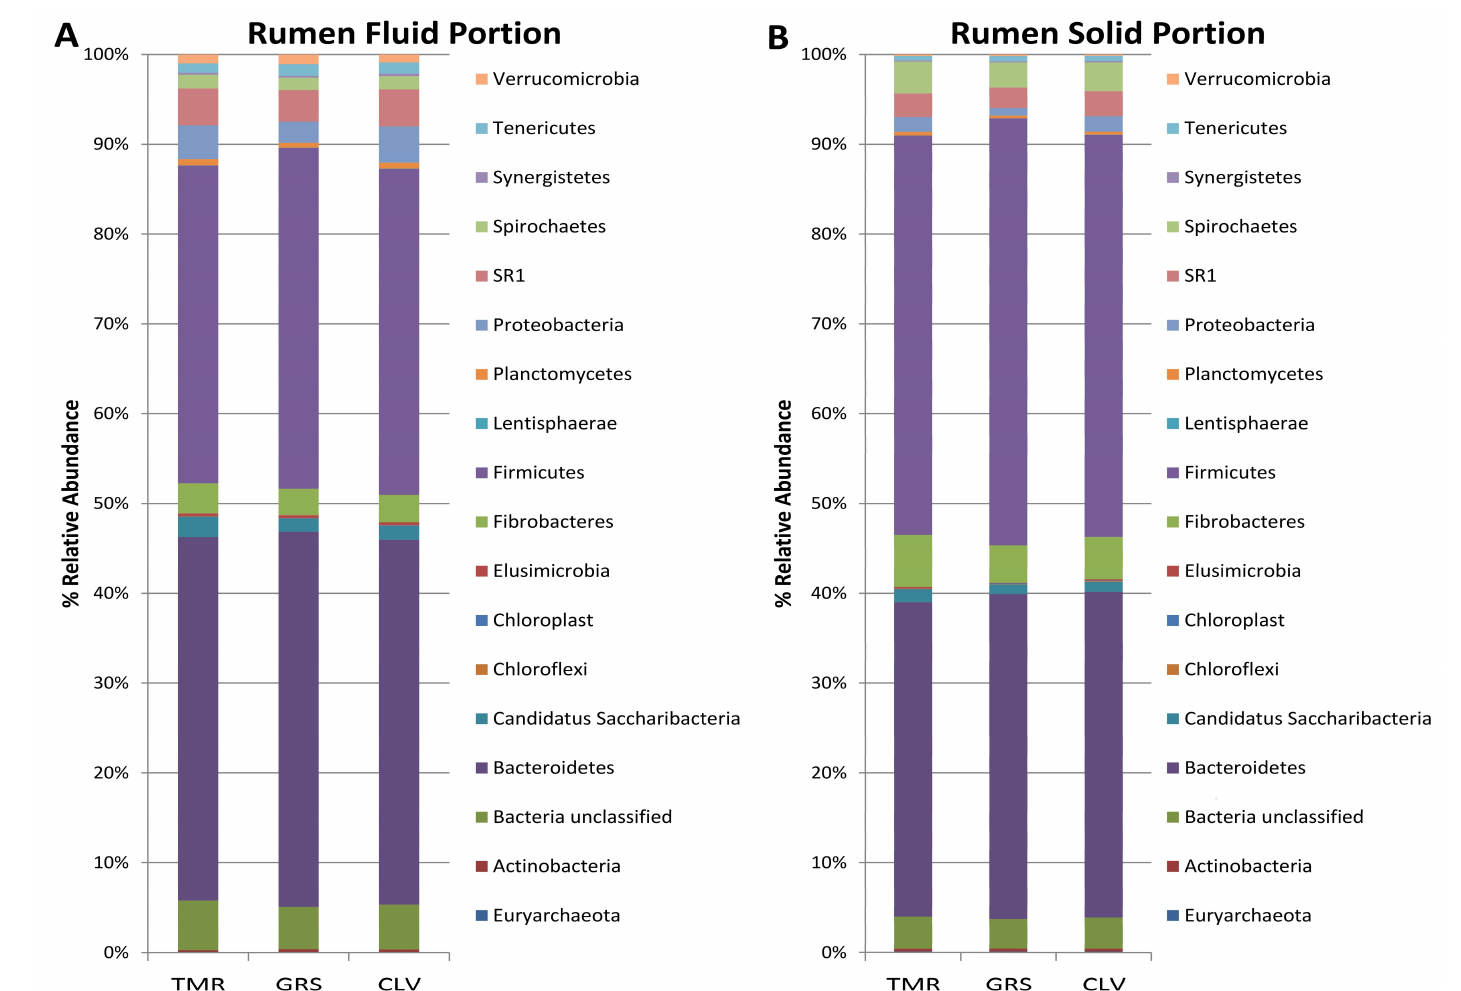
Figure 1. Bar chart demonstrating breakdown of abundances of different phyla in rumen fluid ( A ) and rumen solid ( B ) portions of rumen